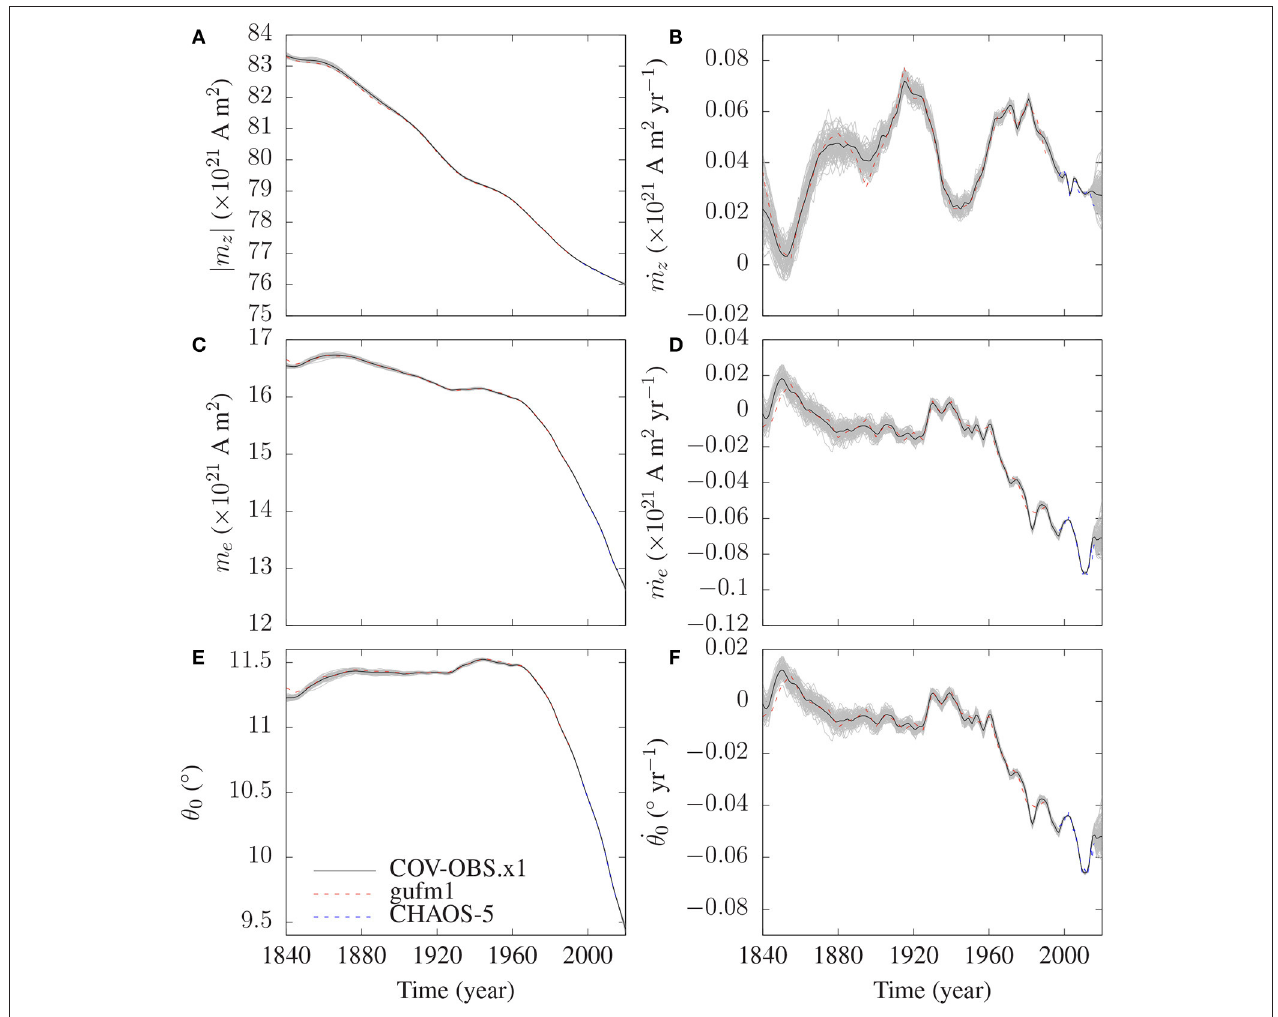
FIGURE 3 | Geomagnetic dipole as a function of time for gufm1 (red dashed line; Jackson et al., 2000), COV-OBS.x1 (black solid line; Gillet et al., 2015) and CHAOS-5 (blue dashed line; Finlay et al., 2015). Gray lines correspond to the ensemble of 100 models of COV-OBS.x1. Absolute axial component | m z | (A) , equatorial component m e (C) and tilt θ 0 (E) and time derivatives of axial component ˙ m z (B) , equatorial component ˙ m e (D) , and tilt ˙ θ 0 (F)